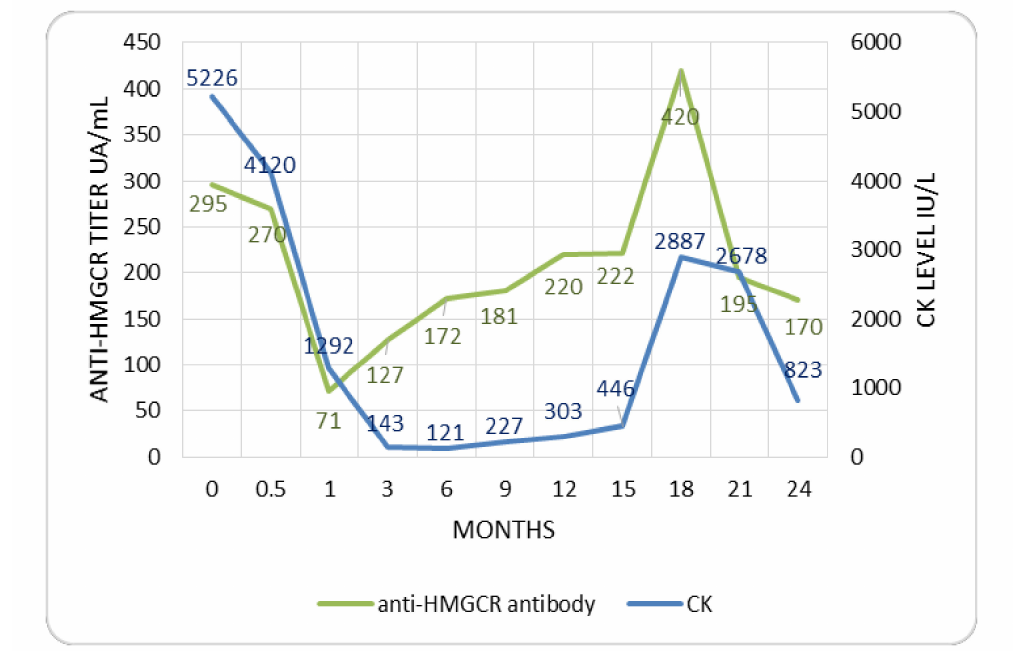
Figure 3. Anti-HMGCR antibody titer and CK level in a relapsing patient. Legend: CK, creatine kinase; anti-HMGCR, anti-hydroxy-methylglutaryl coenzyme A